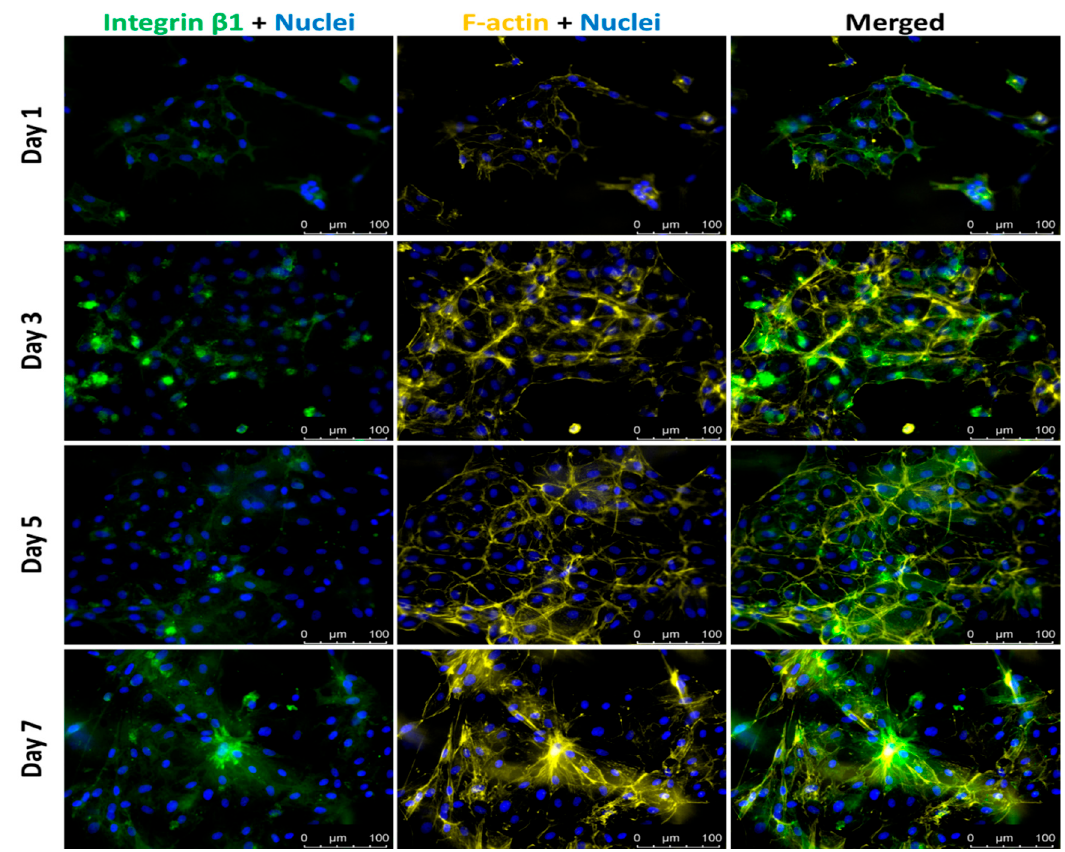
Figure 5. Fluorescent images of VECs on top layer of the VEC-VIC co-culture model. Integrin β 1—Green; F-actin—Yellow; Nuclei—Blue. Scale bar: 100 µm.